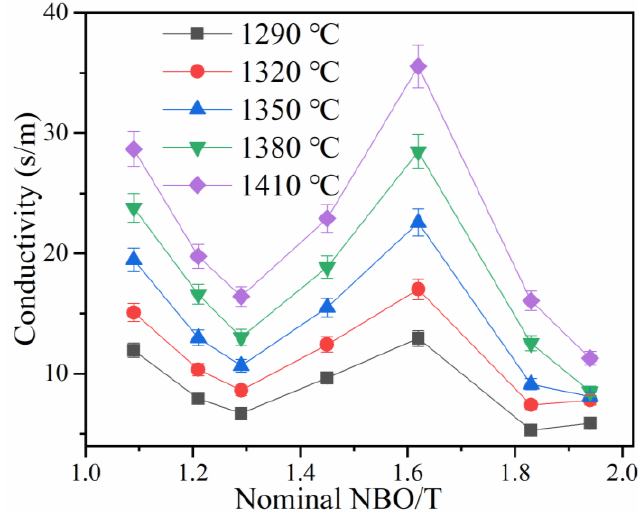
Figure 2. Effect of NBO/T and temperature on slag conductivity.